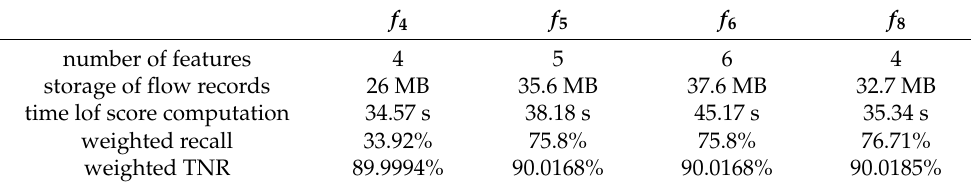
Table 7. Time and computational resources for selected bidirectional (whole) flow.